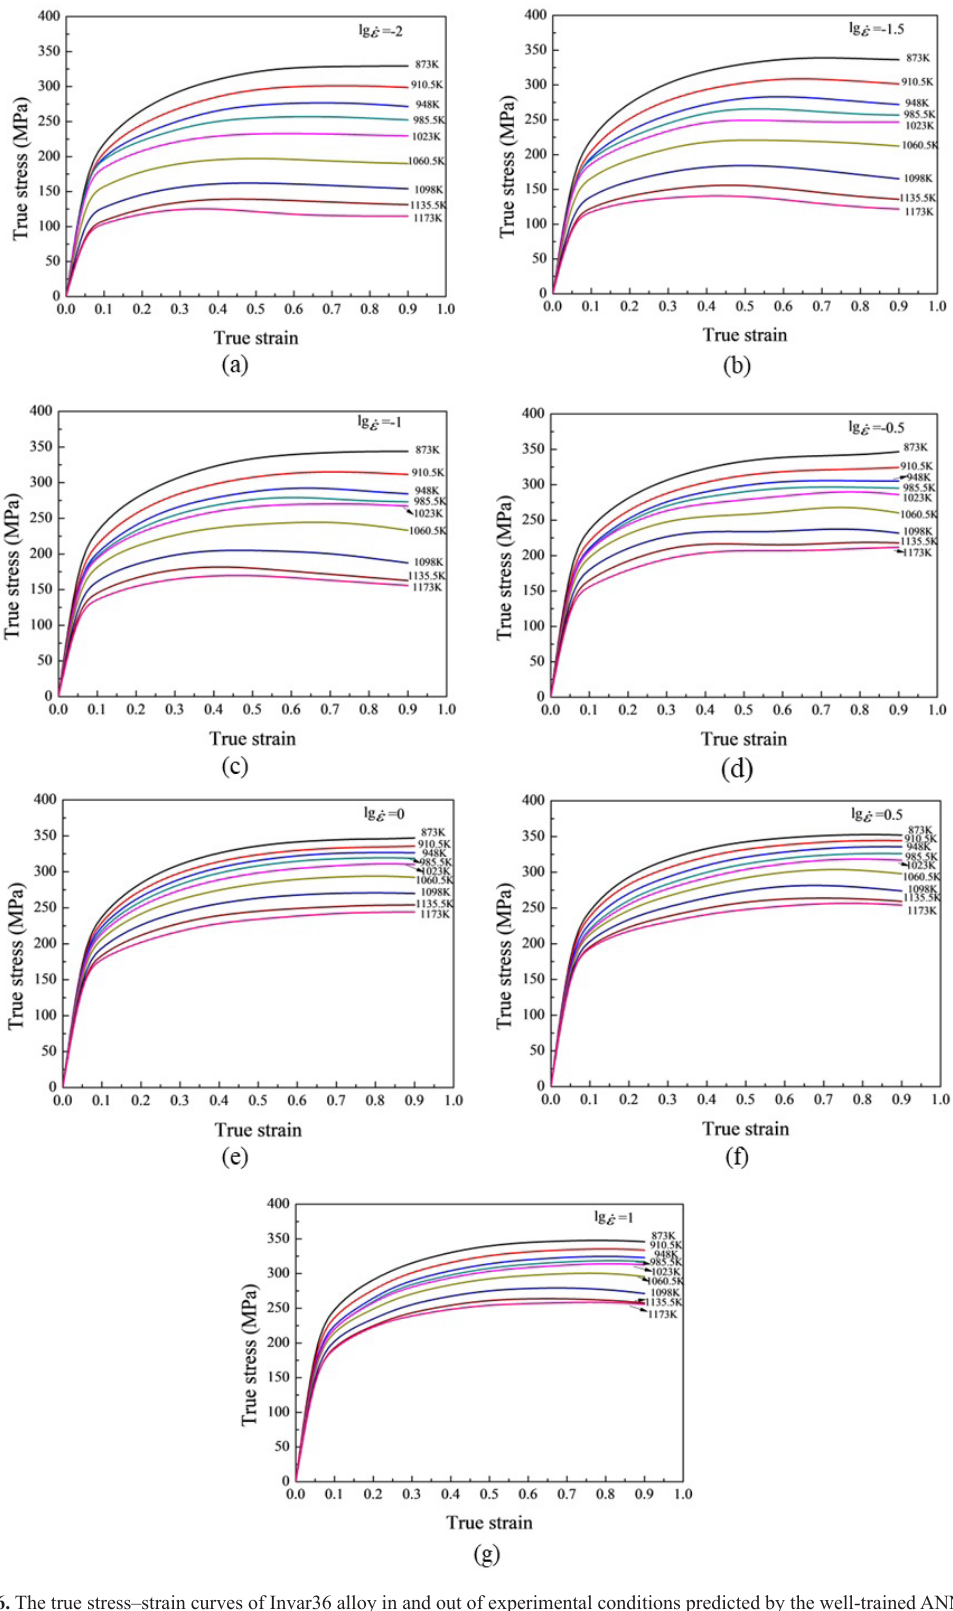
Figure 6. The true stress–strain curves of Invar36 alloy in and out of experimental conditions predicted by the well-trained ANN model with logarithm of strain rate (a) –2, (b) –1.5, (c) –1, (d) –0.5, (e) 0, (f) 0.5 and (g)